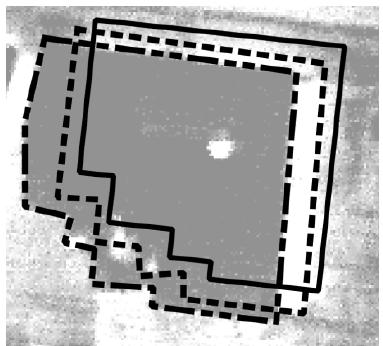
Fig. 1. Contour of the sample building obtained from different data sources. Solid line – OSM data, dotted line – orthophotomap, dashed dot line – thermal image, background layer – thermal